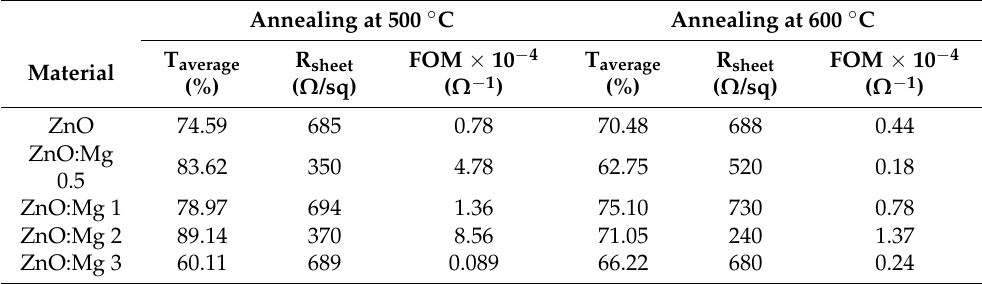
Table 2. Sheet resistance, R sheet , average transmittance (in the spectral range 450–750 nm), T average , extracting the substrate transmittance, and figure of merit, FOM, determined for sol–gel ZnO and ZnO:Mg films.